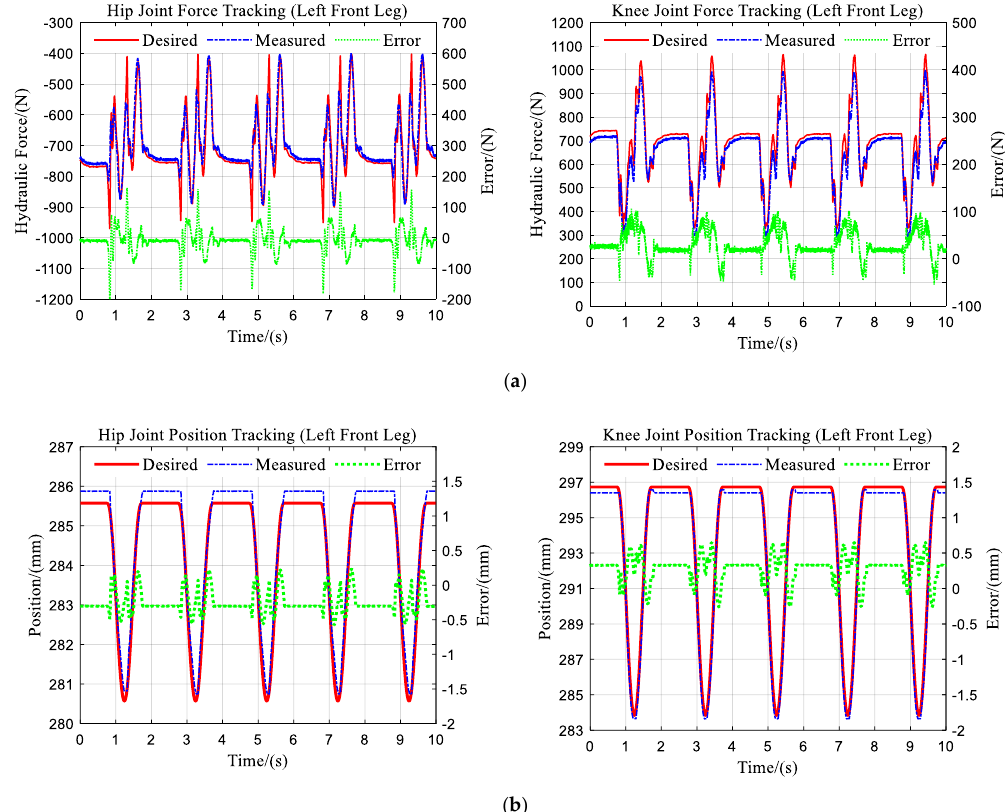
Figure 6. Force/position tracking performance of the active compliance controller on the left front leg. ( a ) Force tracking; ( b ) position tracking.